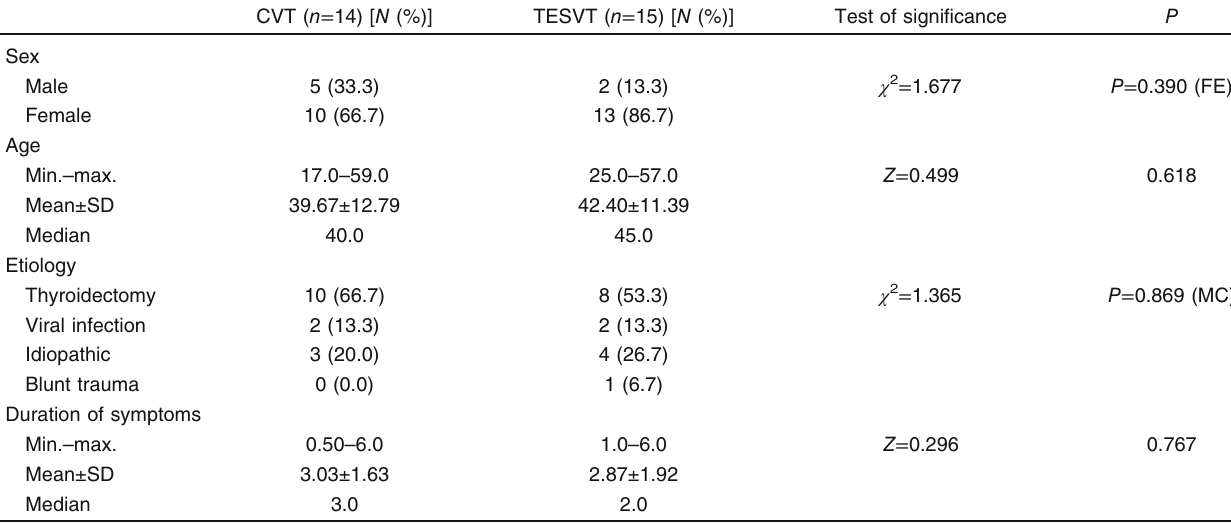
Table 1 Comparison between the studied groups according to demographic data CVT ( n = 14) [ N (%)] TESVT ( n = 15) [ N